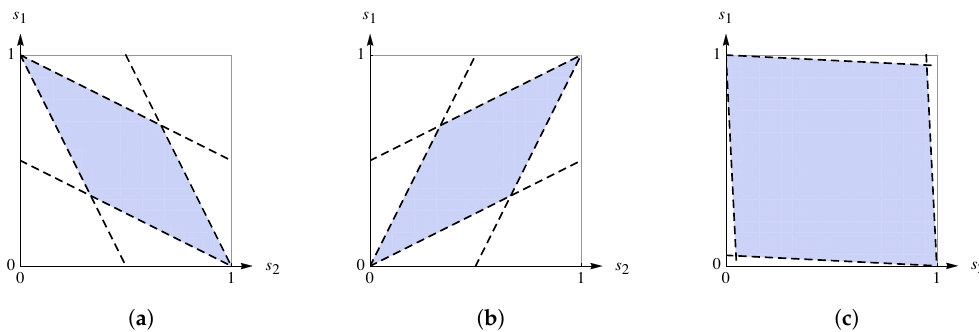
Figure A1. The case a = 0. The shaded regions in ( a – c ) depict the set of all ESDs for the games with b = 1 , − 1 , 1 , c 2 2 20